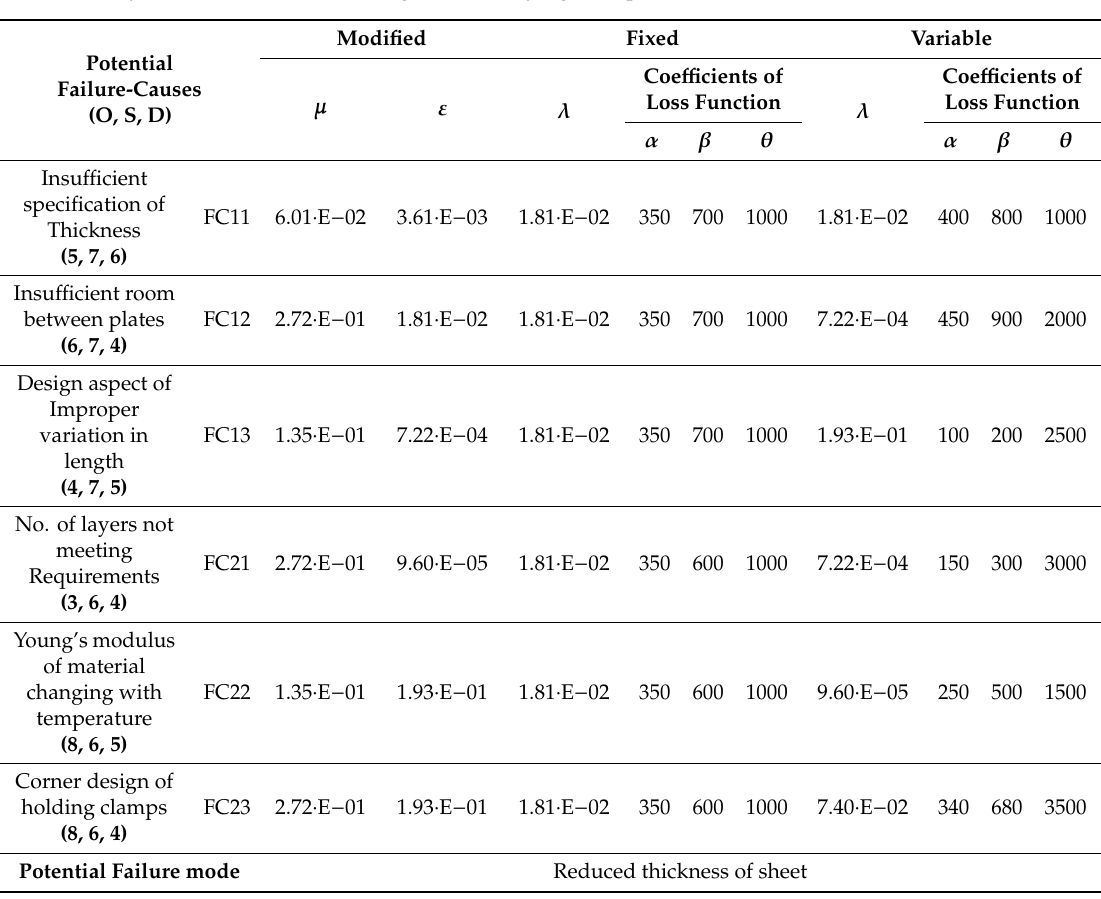
Table 1. Parameter setting for simulations of the time dependent FMEA (TD-FMEA) model for design FMEA: As shown in Equation (11), there are many parameters such as failure-cause detection rate µ , failure-cause occurrence rate ε , failure occurrence rate λ , and coe ffi cients α , β , and θ of loss function L . We set the parameters to compare risk prioritization metric ( RPM ) and risk prioritization number ( RPN ) by various simulations, fixing, and modifying each parameter.